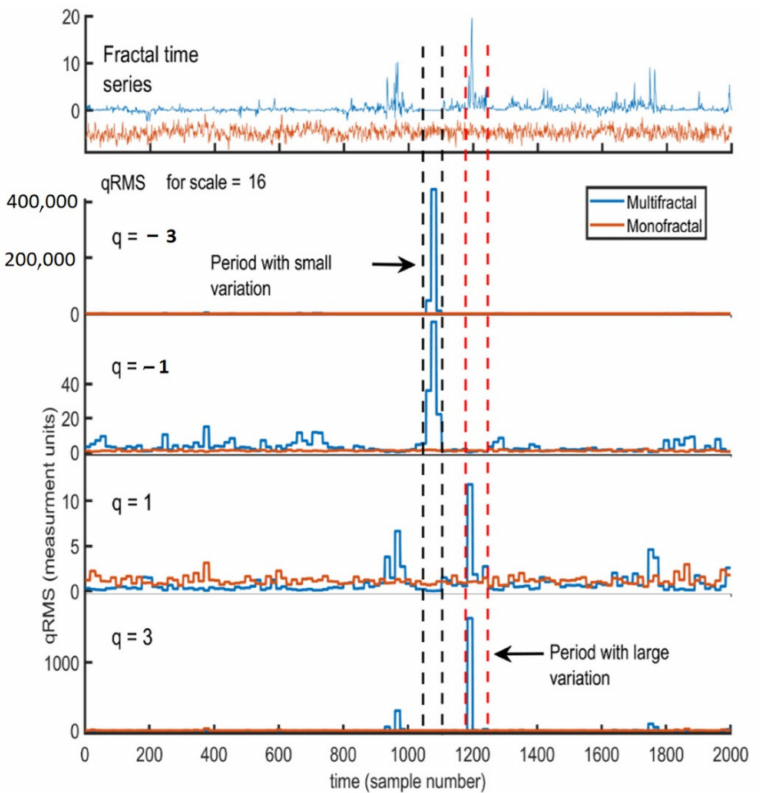
Figure 5. Compute the q-order of the local fluctuations for the multifractal (blue) and monofractal (red) time